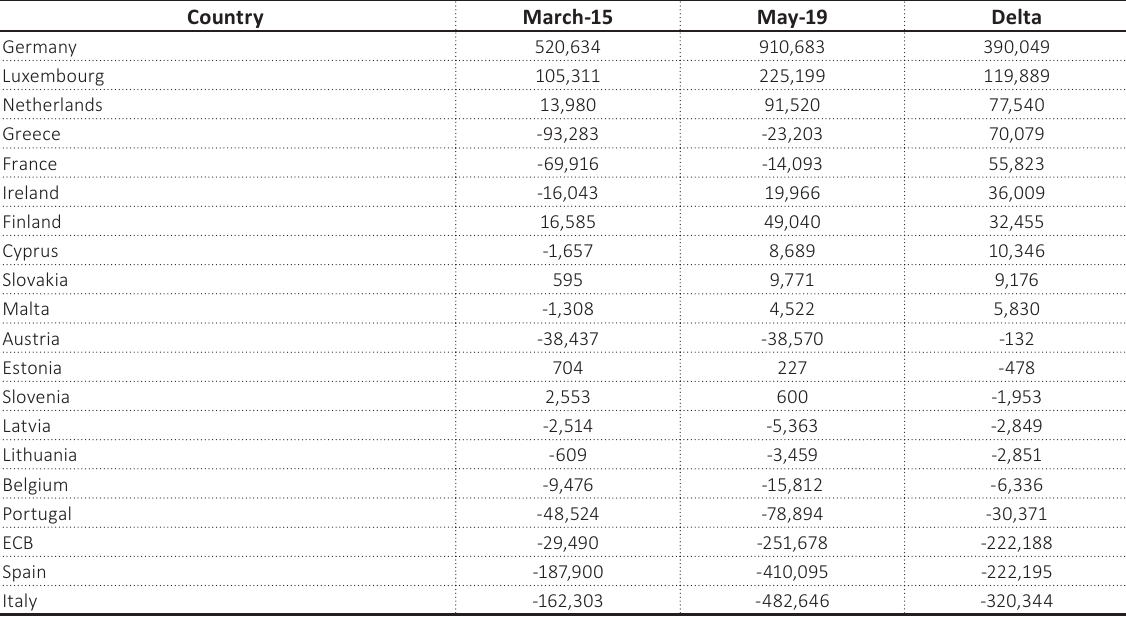
Table 1. T2 balances in million EUR between March 2015 and May 2019 Source: ECB’s Statistical Data Warehouse (monthly averages of daily